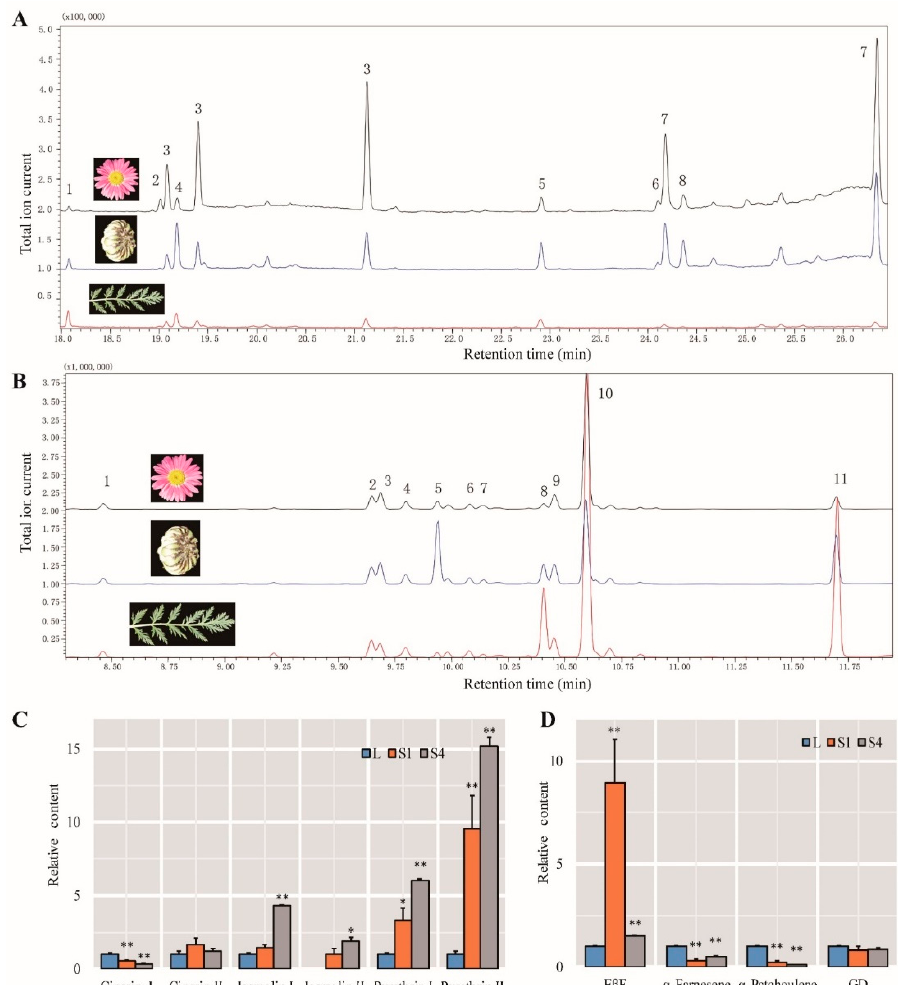
Figure 7. GC-MS analysis of compounds in leaves and flowering stages (S1 and S4). ( A ) Chromatogram profiles of T. coccineum leaves and flowering stages (S1 and S4) for extracts analyzed by GC-MS at the ion current (EIC) for m/z 123 and 107. 1. cinerin I; 2. jasmolin I; 3. pyrethrin I; 4. unknown 1; 5. cinerin II; 6. jasmolin II; 7. pyrethrin II; 8. unknown 2. ( B ) GC-MS analysis of terpene in leaves and flowering stages (S1 and S4) at the ion current (EIC) for m/z 93. 1. Elixene; 2. unknown; 3. caryophyllene I; 4. β -copaene 1; 5. (E)- β -famesene; 6. γ -muurolene; 7. linalool; 8. α -bergamotene; 9. germacrene D; 10. α -farnesene; 11. α -patchoulene. ( C ) The relative content of pyrethrins. The value for L was set as 1 and used as the reference, except for jasmolin II, as its content was too low to measure in the L stages, so the value of S1 stages was set as a reference. ( D ) The relative content of terpenes. The value for L was set as 1 and used as the reference. Error bars represent the standard deviations of the mean values of three replicates, and significant differences (*: p < 0.05; **: p < 0.01) were tested using Student’s paired t